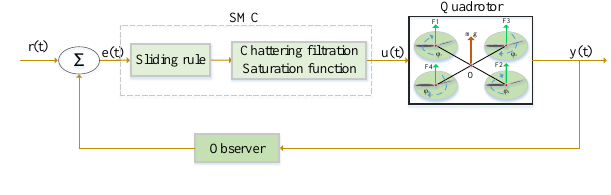
Figure 4. The sliding mode controller